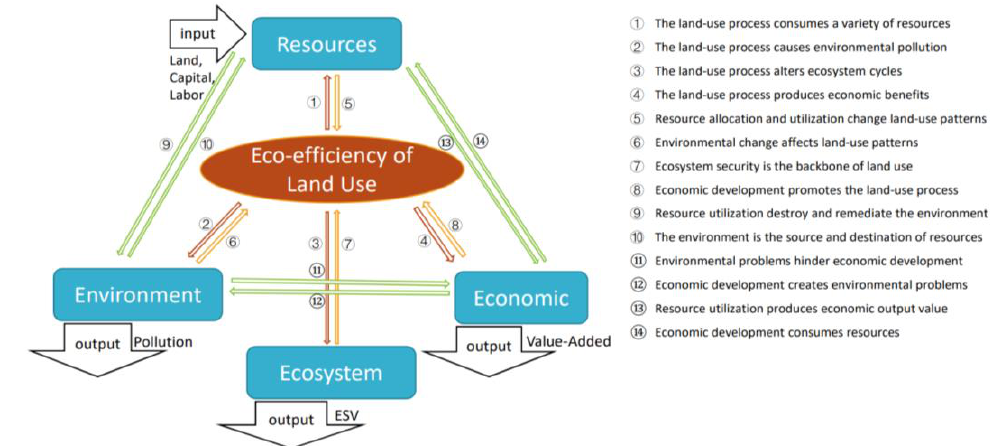
Figure 1. Framework of the input and output factors in the assessment of the ecological efficiency of land use. Source: own elaboration.